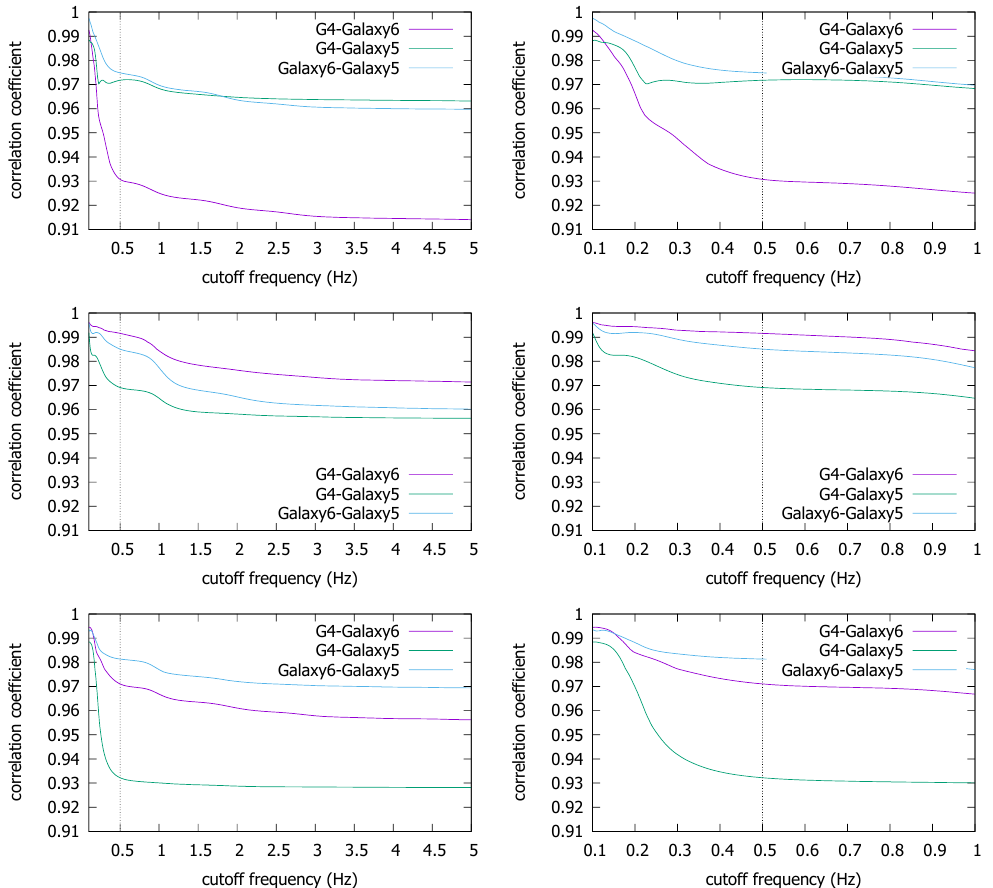
Figure 8. Average ρ max for coexistent traces in the Korea University dataset: ENB ( top ), CTH ( middle ), CSQ ( bottom